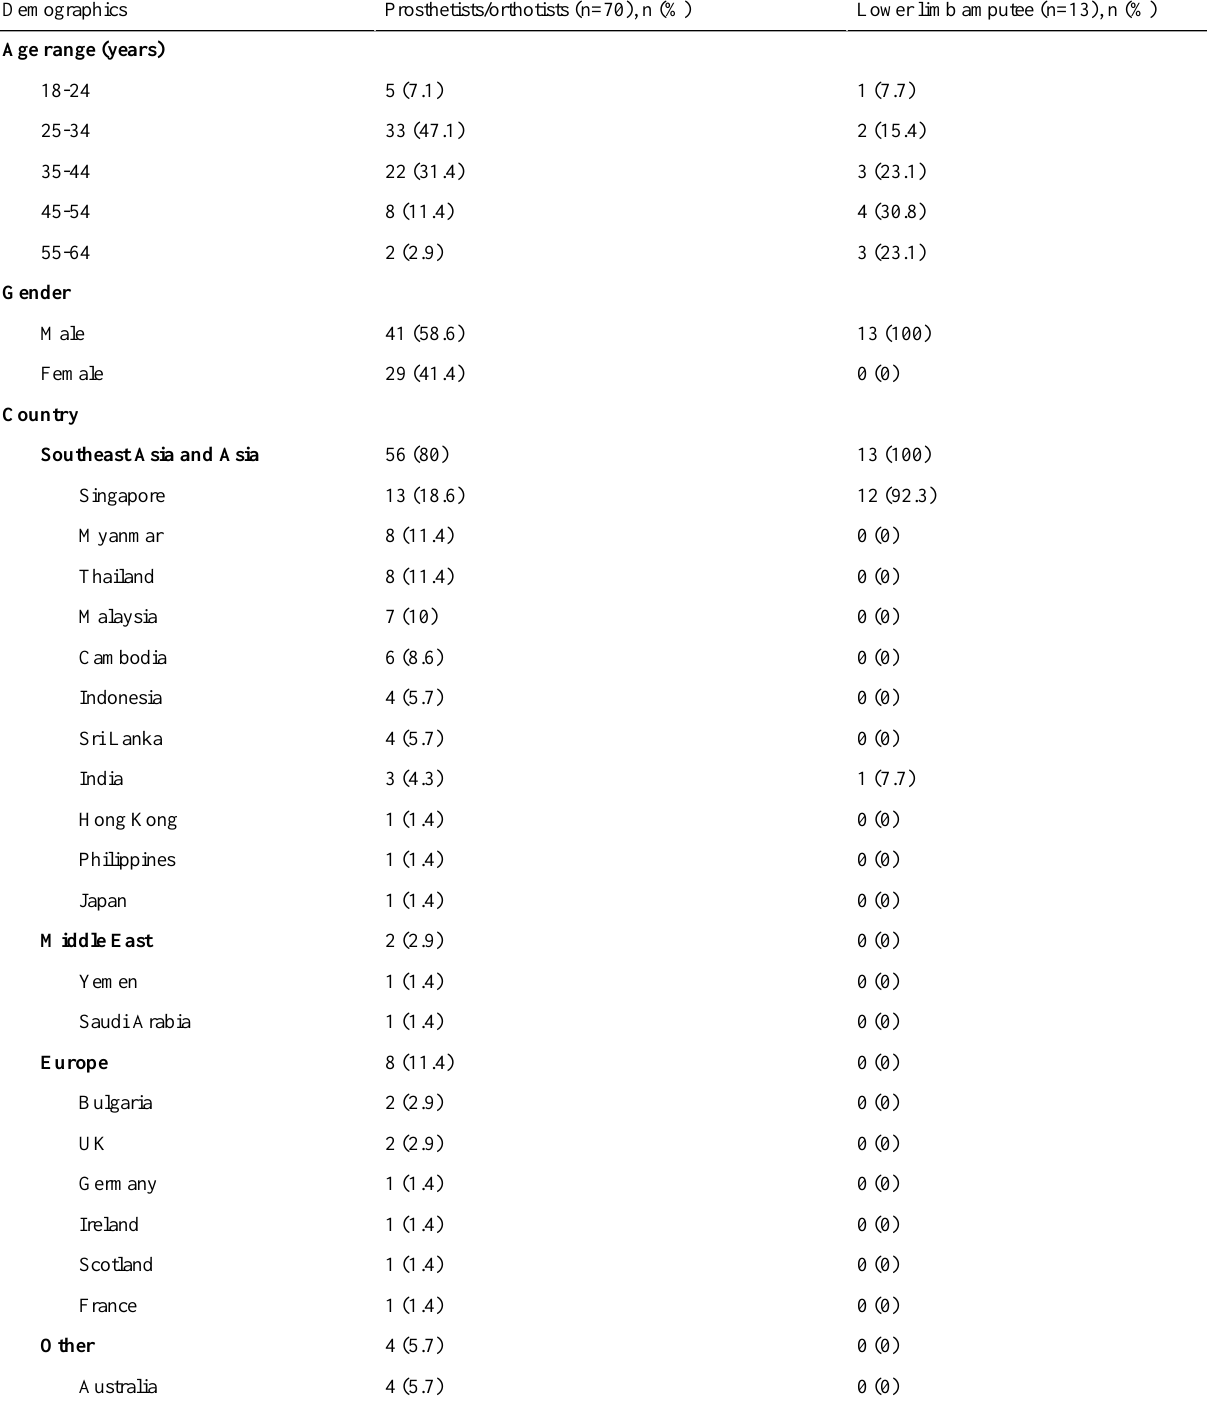
Table 1. Demographics of the